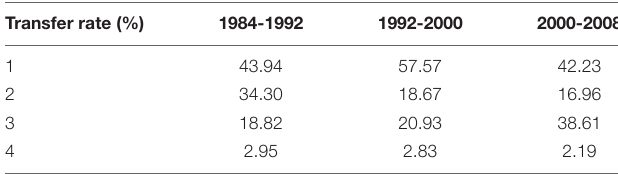
TABLE 4 | The transition rate of landscape in study